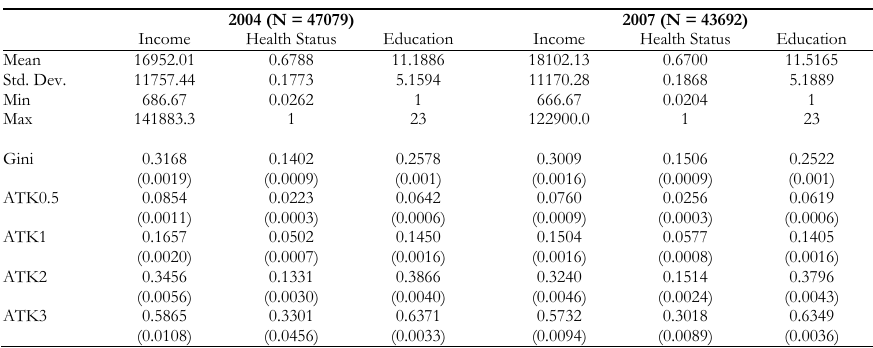
Descriptive statistics and univariate inequality